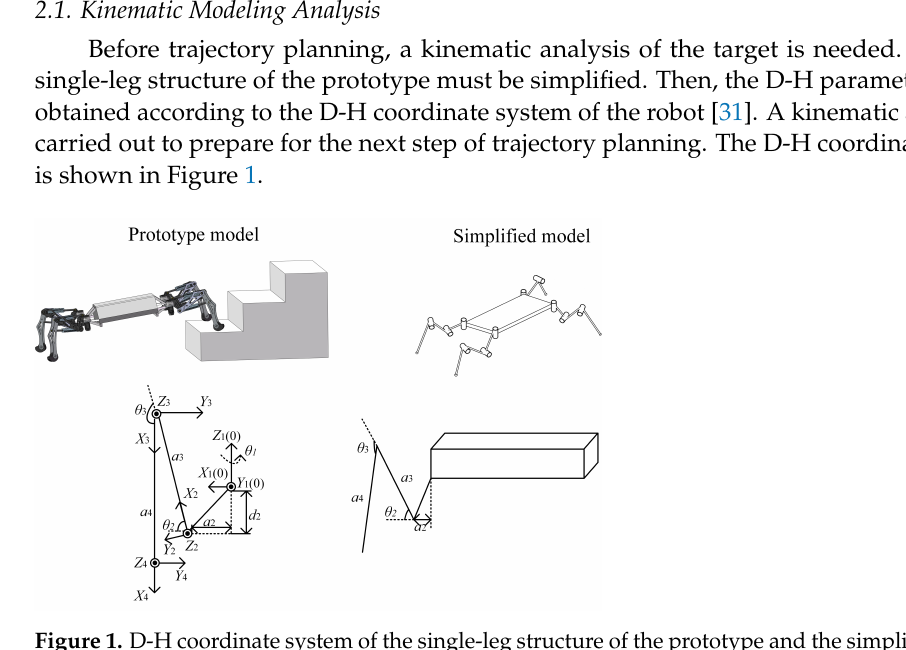
Figure 1. D-H coordinate system of the single-leg structure of the prototype and the simplified